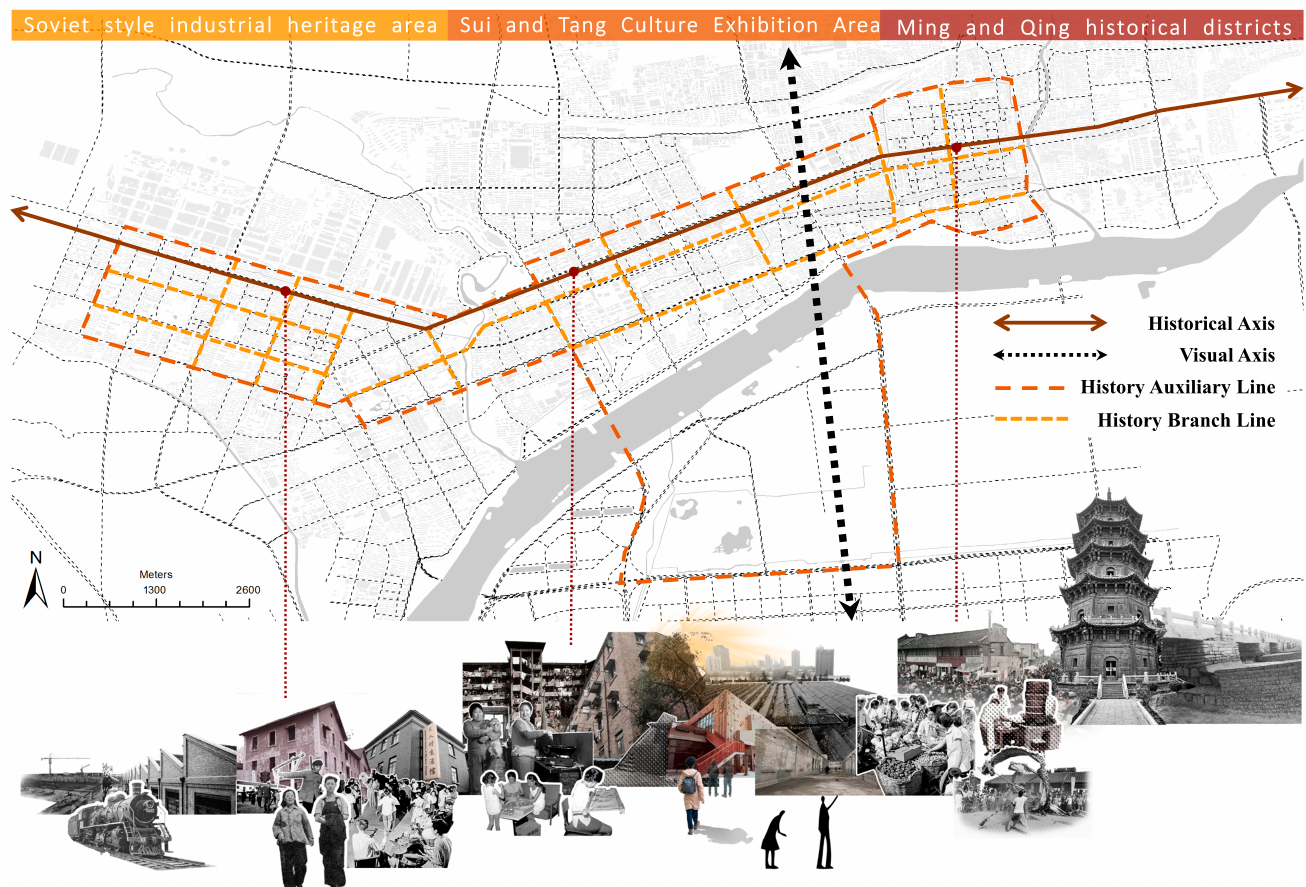
Figure 10. Luoyang urban historic axis system.